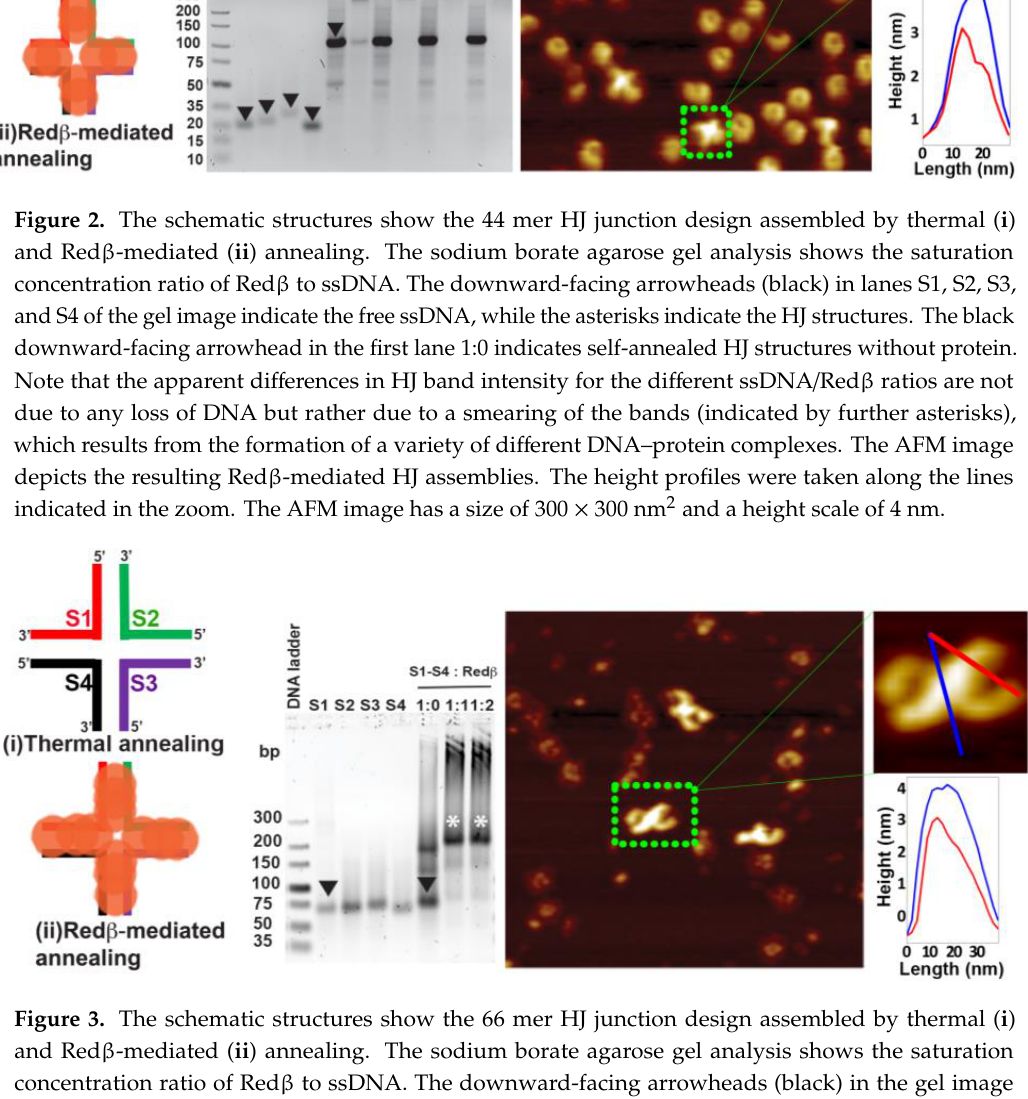
Figure 2. The schematic structures show the 44 mer HJ junction design assembled by thermal ( i ) and Redβ-mediated ( ii ) annealing. The sodium borate agarose gel analysis shows the saturation concentration ratio of Redβ to ssDNA. The downward-facing arrowheads (black) in lanes S1, S2, S3, and S4 of the gel image indicate the free ssDNA, while the asterisks indicate the HJ structures. The black downward-facing arrowhead in the first lane 1:0 indicates self-annealed HJ structures without protein. Note that the apparent differences in HJ band intensity for the different ssDNA/Redβ ratios are not due to any loss of DNA but rather due to a smearing of the bands (indicated by further asterisks), which results from the formation of a variety of different DNA–protein complexes. The AFM image depicts the resulting Redβ-mediated HJ assemblies. The height profiles were taken along the lines indicated in the zoom. The AFM image has a size of 300 × 300 nm² and a height scale of 4 nm.